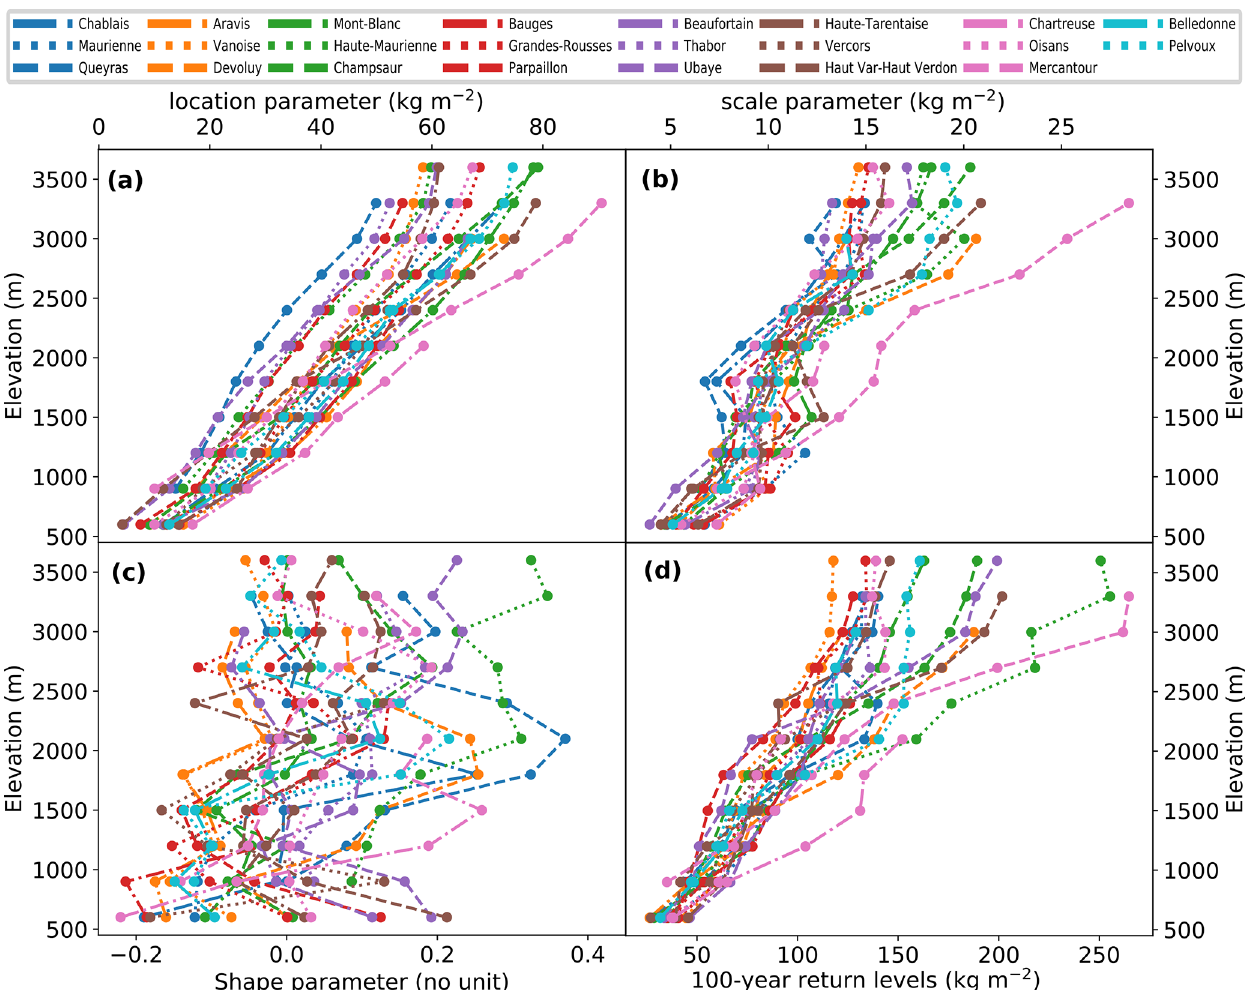
Figure 2. Changes in GEV parameters (a–c) and in 100-year return levels (d) with the elevation for the 23 massifs of the French Alps. GEV distributions are estimated pointwise for the annual maxima of daily snowfall every 300m of